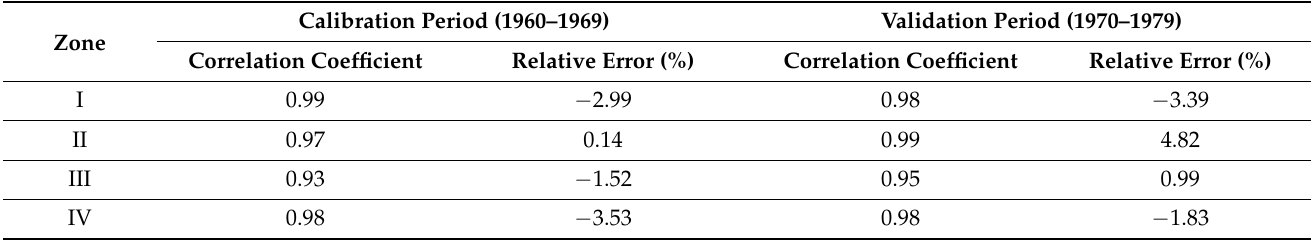
Figure 4. The measured total snowfall and estimated total snowfall in different zones of the Haihe River Basin. ( a ) Zone I, ( b ) Zone Ⅱ , ( c ) Zone Ⅲ , ( d ) Zone Ⅳ . Table 3. The results of correlation coefficient and relative error in calibration and validation period.